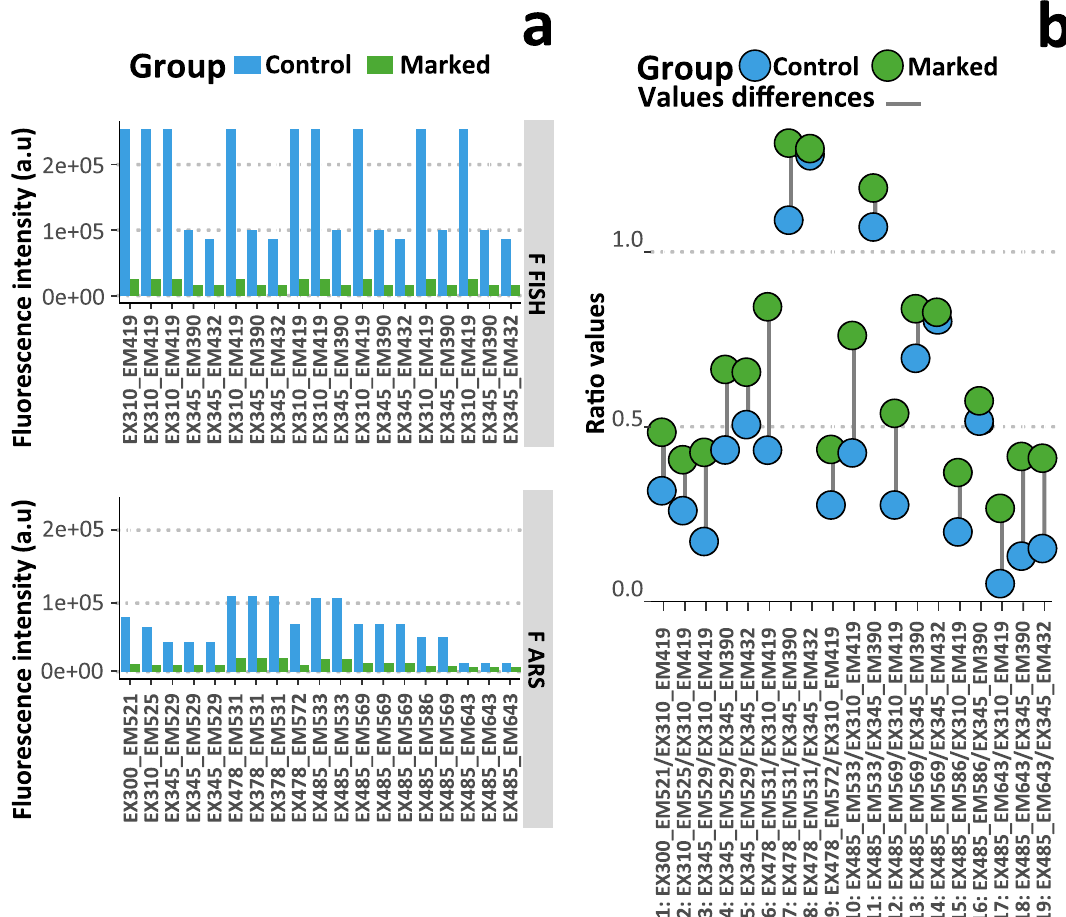
Figure 5. Fluorescence peaks and their ratios. ( a ) Graph plot of the fluorescence intensities of peaks within the alizarin signal (F ARS ) and within the natural fish signal (F FISH ) used in the alizarin fluorescence ratios (R n ). ( b ) Graph of the values of the 19-alizarin fluorescence ratios (R n n:1 → 19 ) that discriminated the marked (n = 12) from the control (n = 12) glass eels. The grey lines represent the differences in the ratios values between the groups. R is the ratio of F ARS to F FISH